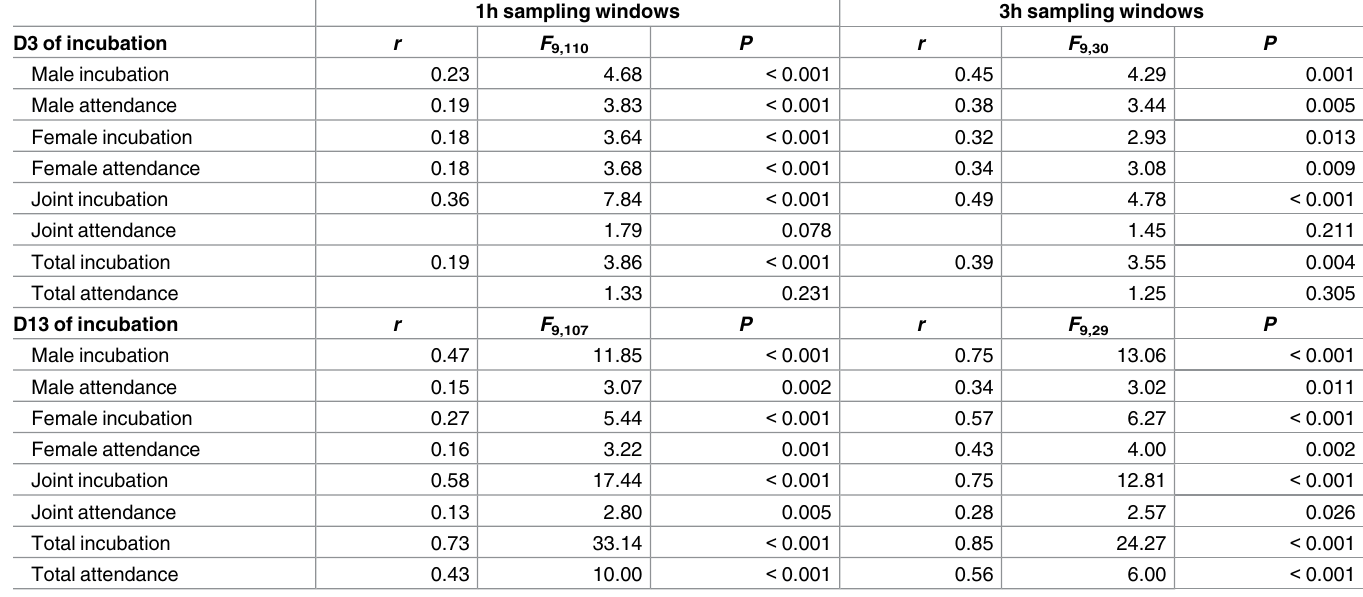
Table 1. Consistency of parental effort over the course of the day using 1h and 3h sampling windows on day 3 and day 13 of incubation,